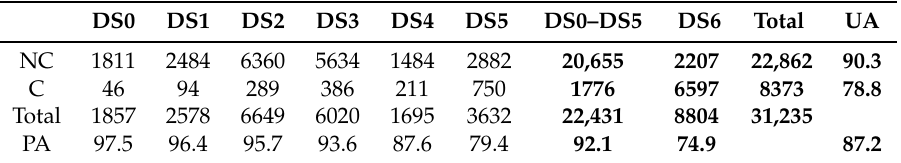
Table 5. Accuracy evaluation of the classification results for collapsed and non-collapsed buildings obtained from a 7-dimensional dataset using a non-linear discriminant function based on the fragility function of Suppasri et al.